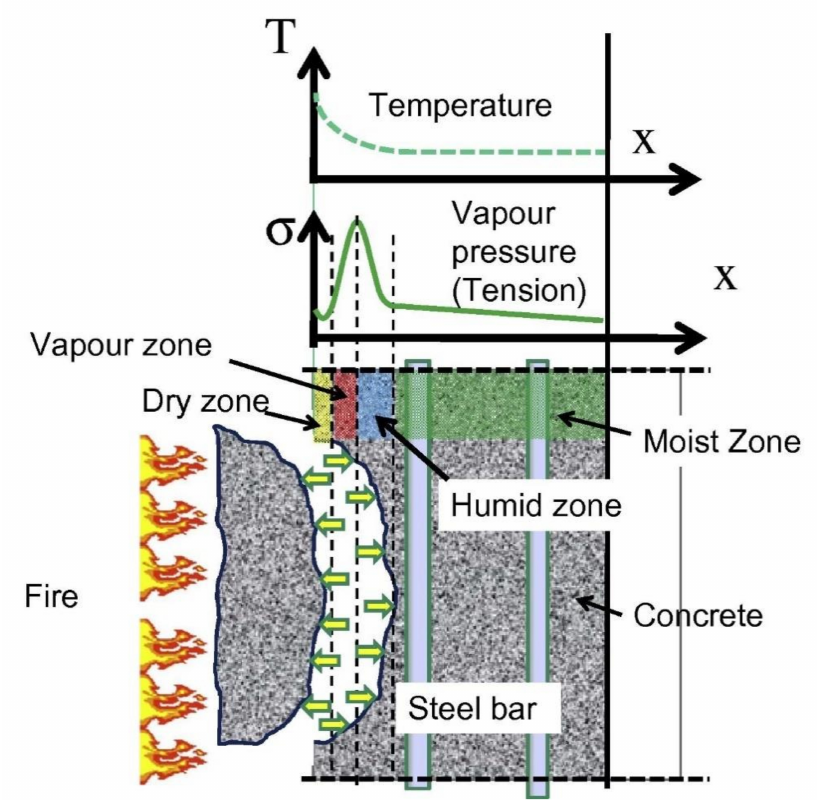
Figure 1. Mechanism of spalling of concrete due to vapour pressure [117].